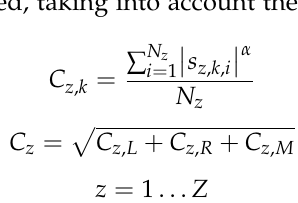
Figure 2. Generalized evaluation of the discrepancies’ impact on the task.